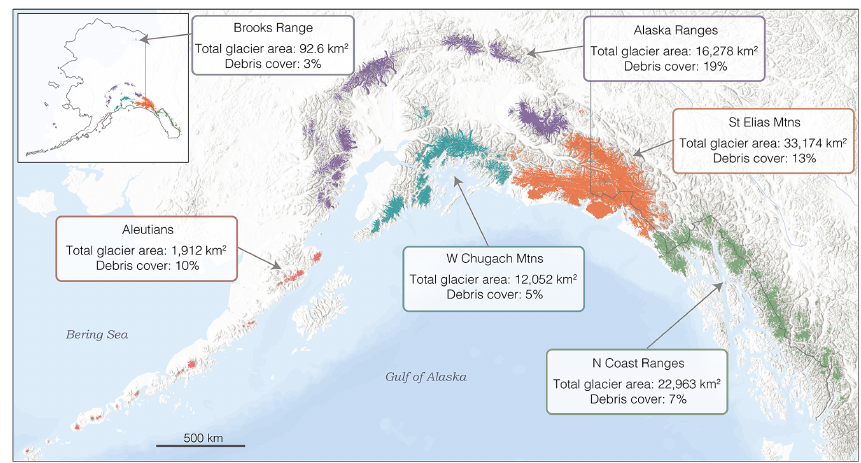
Figure 1. Distribution of glaciers as mapped by the Randolph Glacier Inventory (RGI Consortium, 2017) and subregions used to separate glaciated areas in Alaska and NW Canada (basemap provided by ESRI, 2009). Total glacier area (km 2 ) and percent debris cover (percent of glacier surface covered by debris; Herreid and Pellicciotti, 2020) are displayed for each subregion.